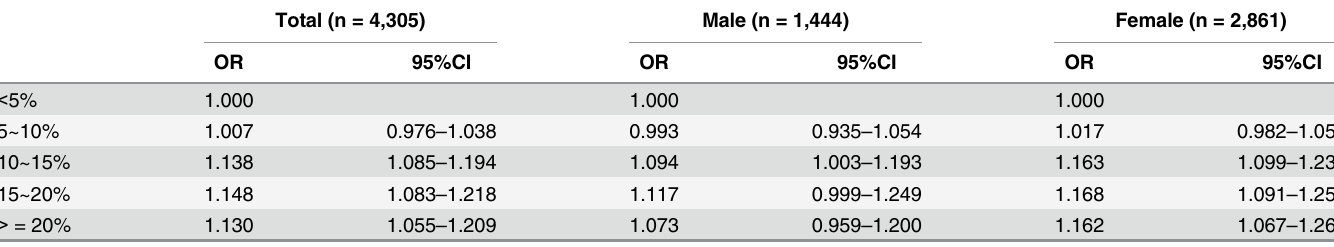
Table 5. ORs for hyperuricemia with 5% increases in the